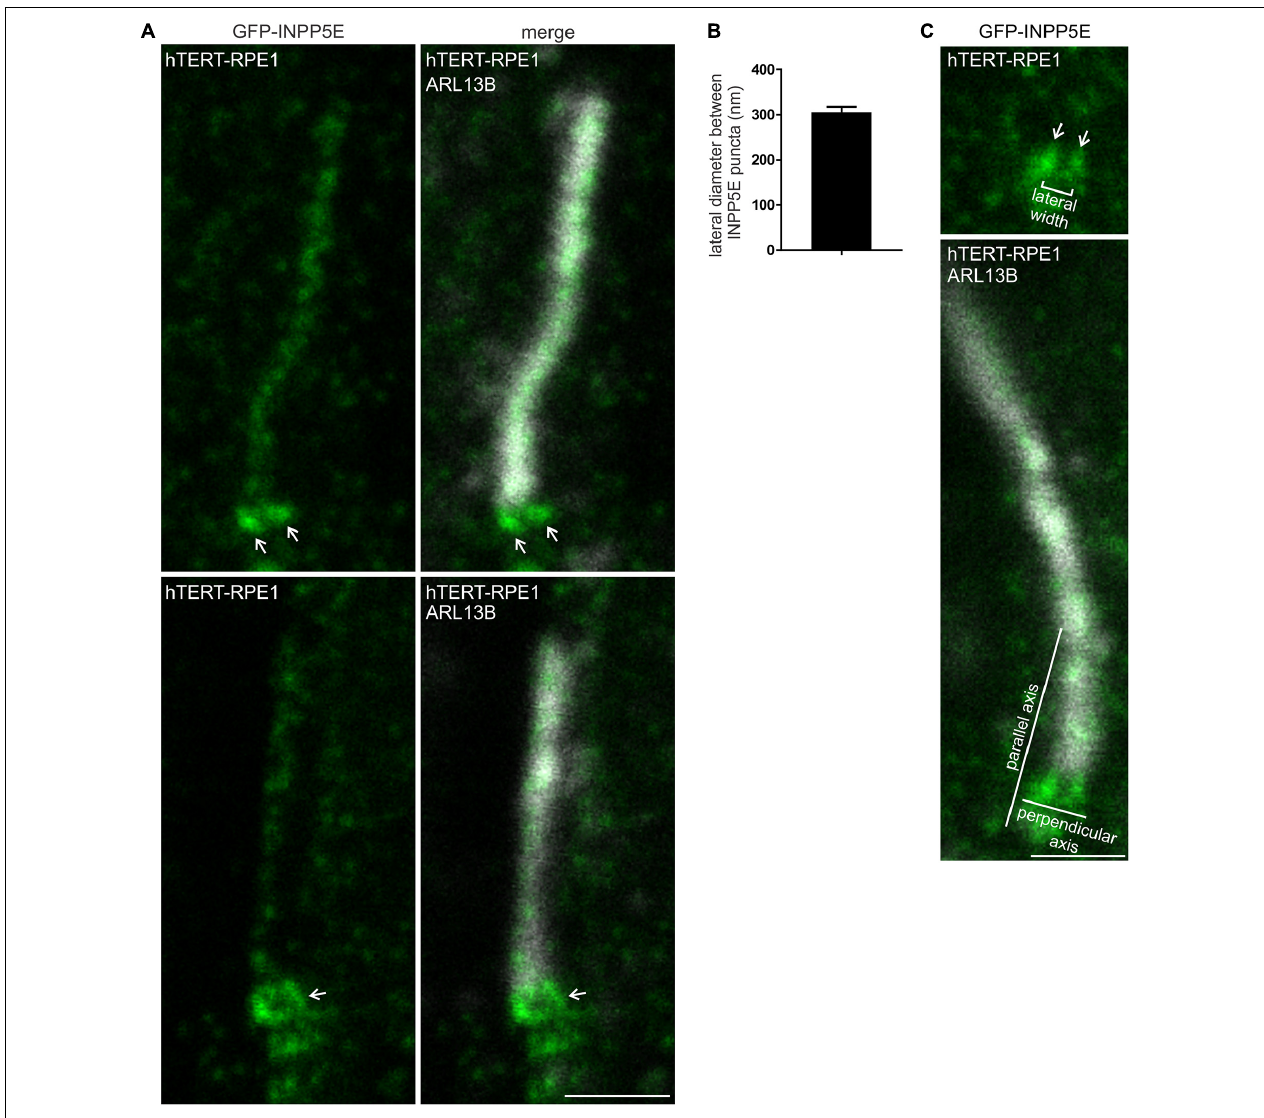
FIGURE 8 | INPP5E exhibits a ring-shaped localization at the transition zone. (A) hTERT-RPE1 cells were transfected with GFP-INPP5E, serum starved and immunostained with GFP (green) and ARL13B (grayscale) antibodies and imaged by STED microscopy (confocal resolution image of the ARL13B stained axoneme is shown). Arrows indicate transition zone INPP5E localization, bar indicates 1 µ m. (B) Graph shows the lateral diameter between the highest intensity points of the INPP5E transition zone protein puncta perpendicular to the plane of the axoneme. Bars represent mean ± SEM, n = 3 independent experiments, 30 cilia imaged per experiment and all cilia with two distinct INPP5E puncta measured. (C) Example image showing method for the lateral diameter and axial distance measurements, bar indicates 1 µ